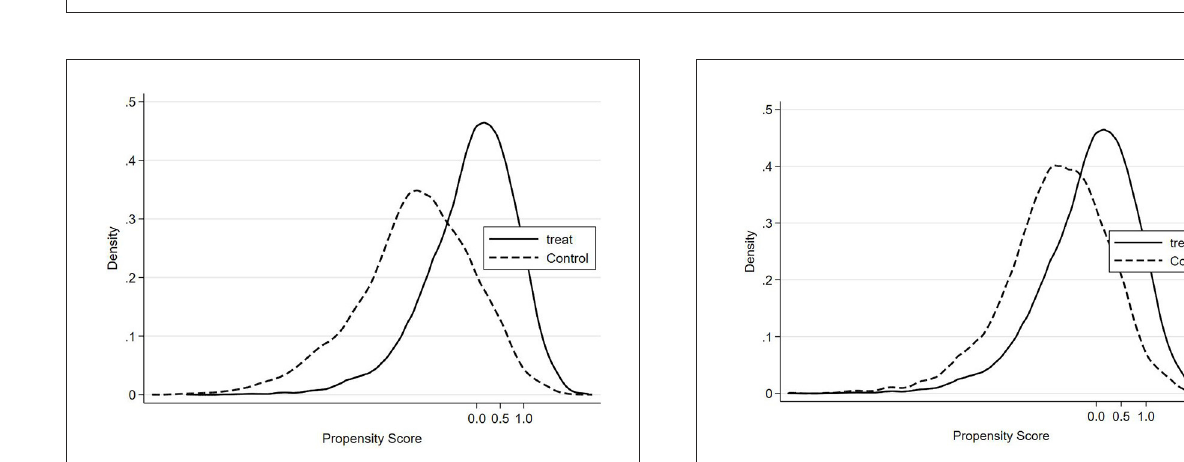
FIGURE1 Standardized bias before and after matching.